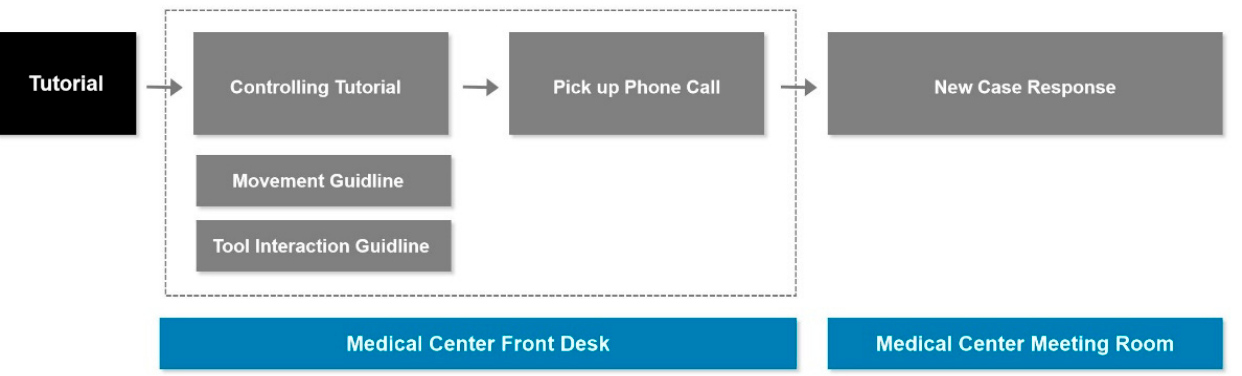
Figure 8. Tutorial Module Exploring Flow.